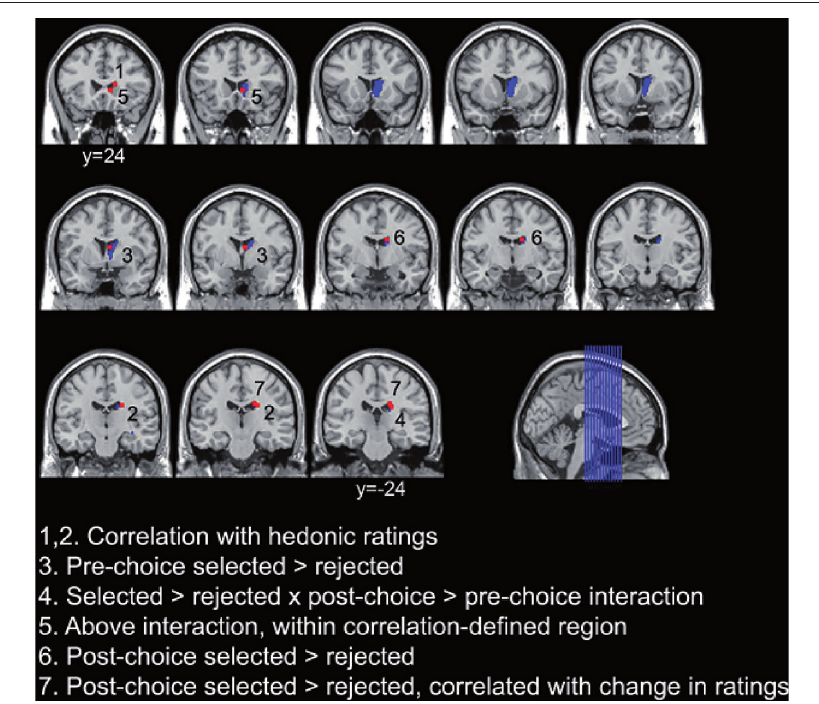
FIGURE 1 | Illustration of the anatomical variability in activation of the caudate nucleus across the various contrasts in Sharot et al. (2009) study. Voxel-sized boxes (2 × 2 × 3 mm) centered on the peak co-ordinates for each of the contrasts are overlaid in red on the SPM5 T1 template brain. The right caudate nucleus, defi ned according to the Talairach Daemon atlas using the WFU PickAtlas tool, is additionally overlaid in blue. Slices are displayed from y = − 24 to y = 24 in increments of 4